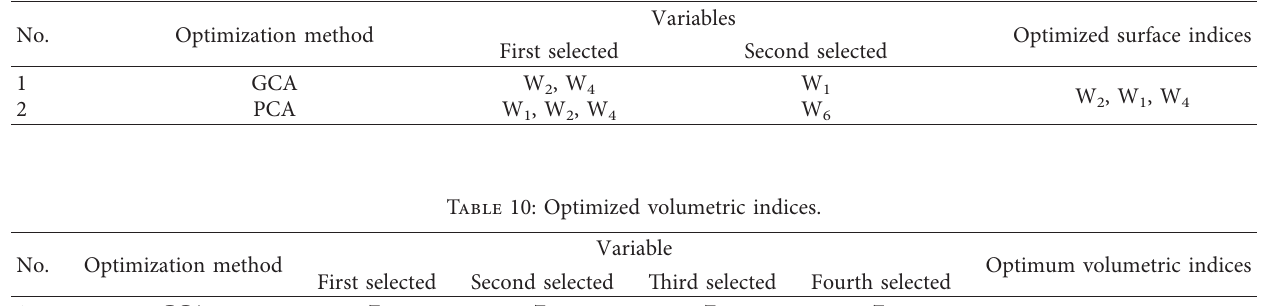
Table 9: Optimized surface indices.